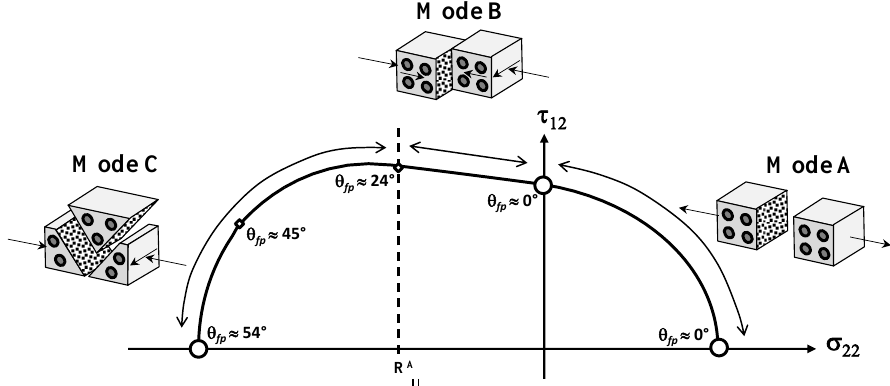
Figure 4. Fracture curve on the stress space σ 22 × τ 12 for an intrinsically brittle material (Adapted from